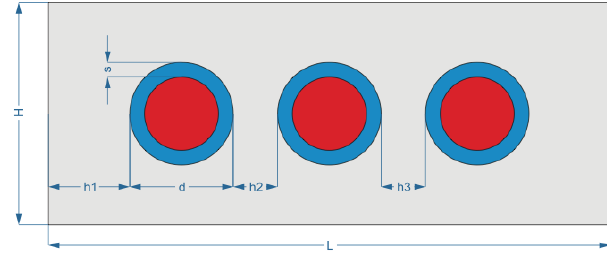
Fig. 3. An example of